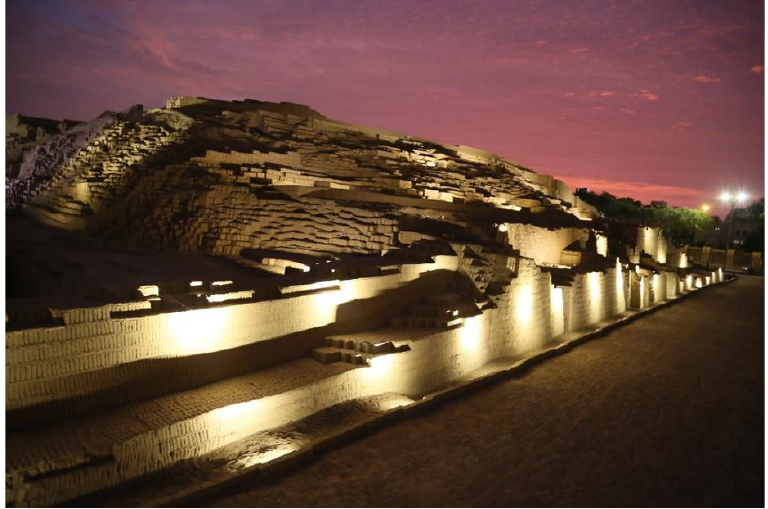
Figure 5. Huaca Pucllana. Resource: https://www.miraflores.gob.pe/la-ciudad/ (accessed on 5 November 2022).